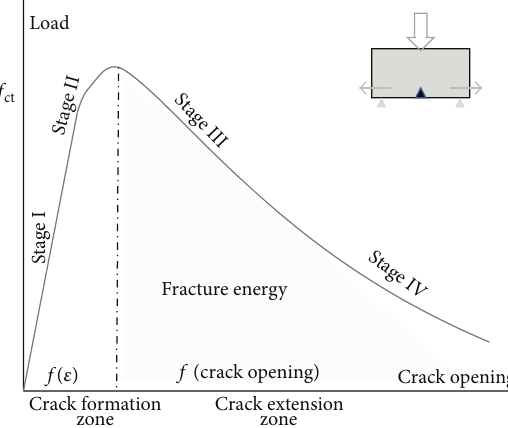
Figure 1: Fracture model of three-point bending crack opening test.